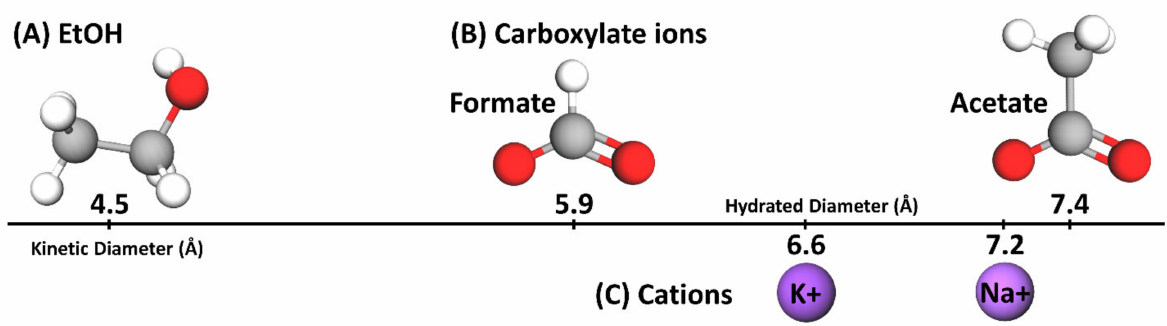
Figure 3. Molecular structure of ( A ) EtOH (4.5 Å), ( B ) carboxylate ions, OFm − (5.9 Å) and OAc − (7.4 Å) and ( C ) cations, K + (6.6 Å) and Na + (7.2 Å), where kinetic diameters are stated for EtOH and hydrated diameters are stated for ions. Carbons are shown in grey, oxygens are shown in red, hydrogens are shown in white, K + is shown in a darker purple, and Na + is shown in a lighter